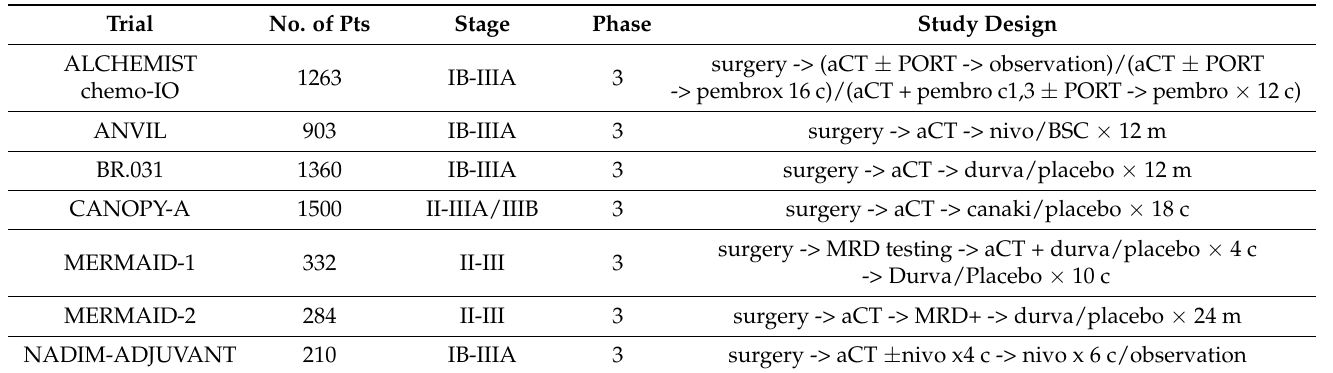
Table 4. Trials of adjuvant immunotherapy in resectable early NSCLC (ongoing or results